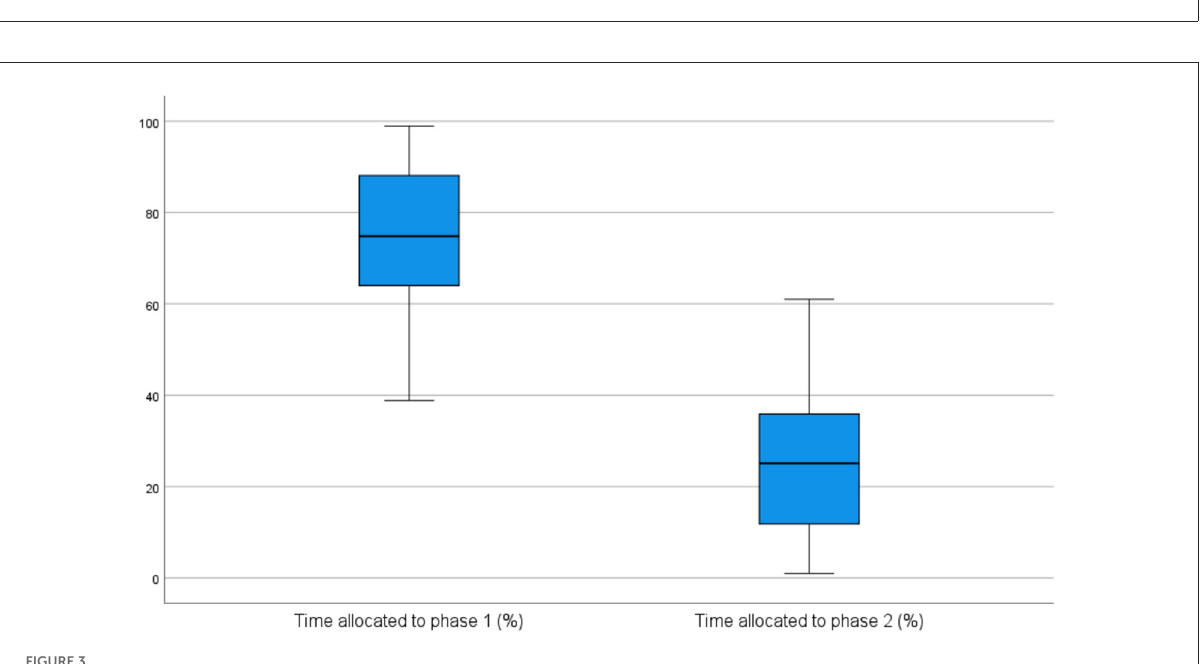
FIGURE3 Time distribution across phases in post-test